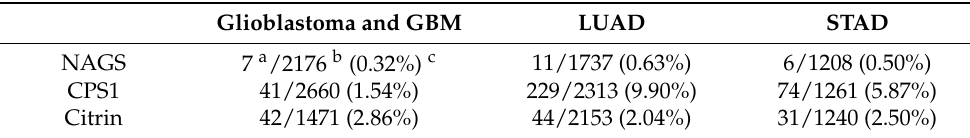
Table 1. Number and fraction of glioblastoma, glioblastoma multiforme (GBM), lung adenocarcinoma (LUAD), and stomach adenocarcinoma (STAD) samples with sequence variants in NAGS , CPS1, and citrin genes. Glioblastoma and GBM LUAD STAD NAGS 7 a /2176 b (0.32%) c 11/1737 (0.63%)